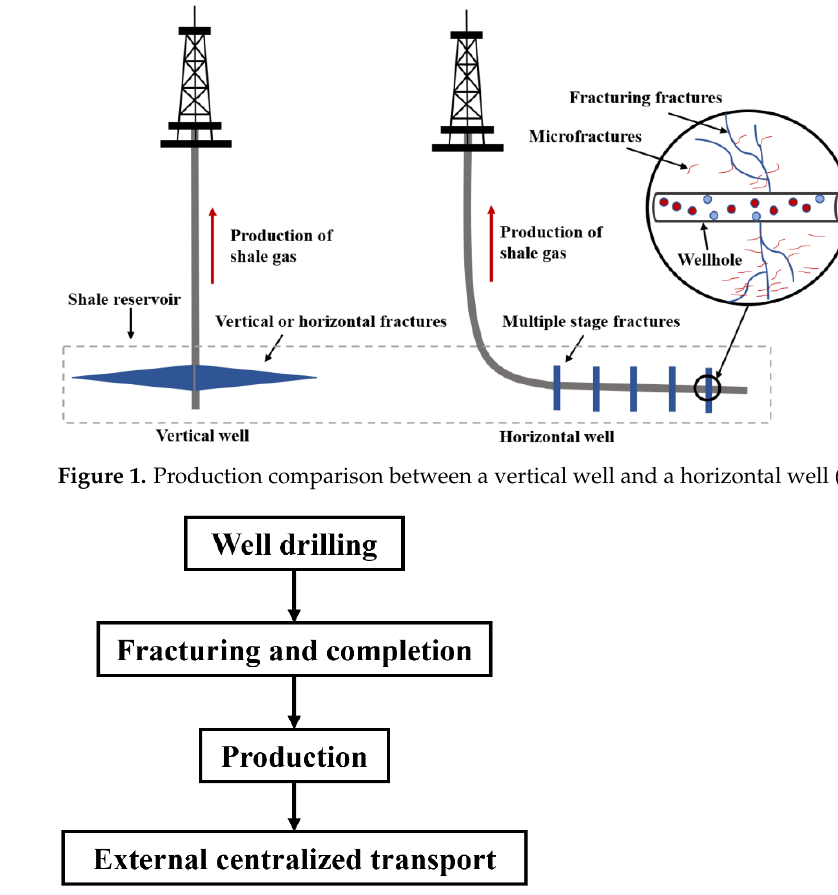
Figure 2. Production process of shale condensate gas reservoirs (modified from [15]).